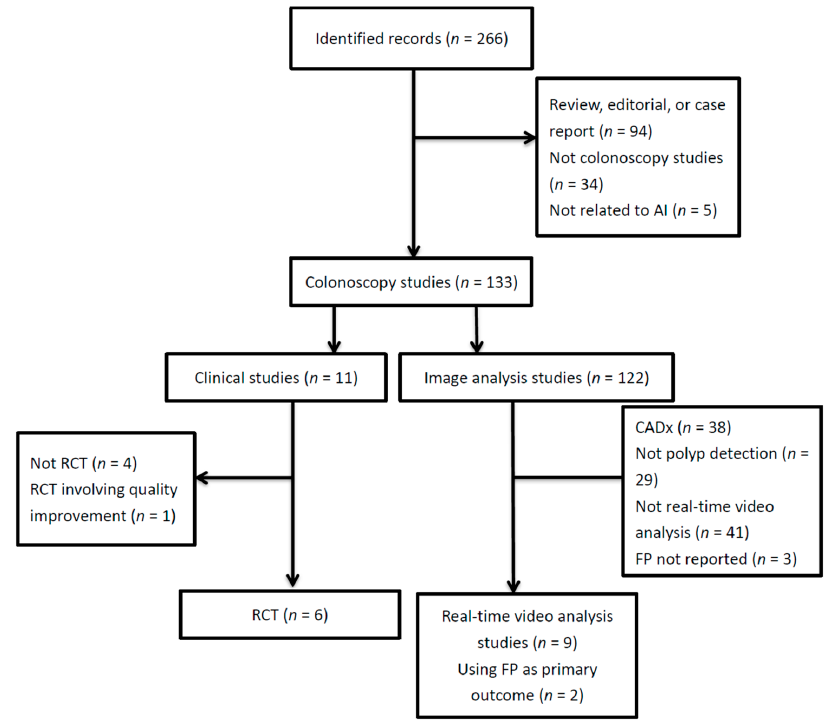
Figure 1. Literature flow diagram. AI, artificial intelligence; CADx, computer-aided diagnosis; FP, false positive; RCT, randomized controlled trial.